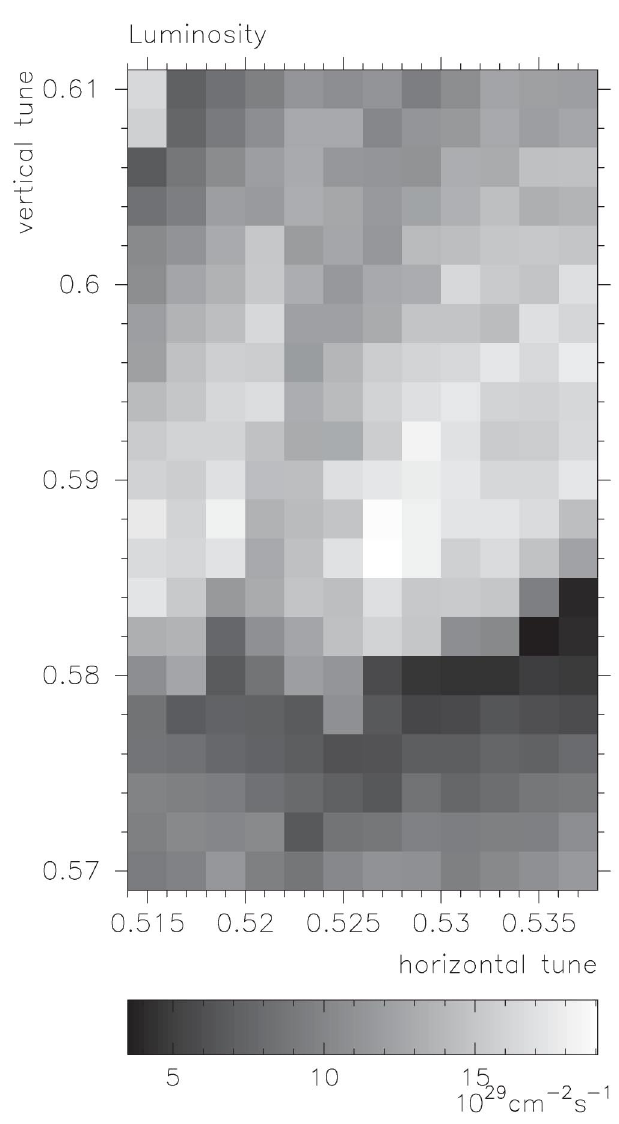
FIG. 9. Luminosity is computed for each combination of ver- tical and horizontal tune in the plotted grid. The synchrotron tune (cid:1) 0 : 089 . Maximum luminosity occurs for Q is Q s (cid:1) 0 : Q y